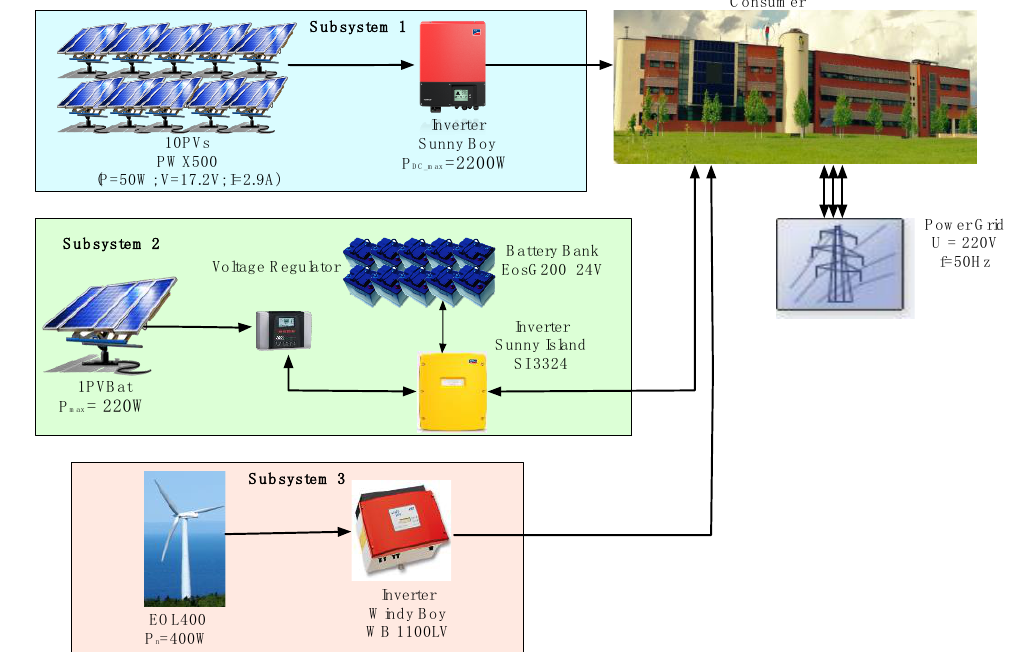
Figure 2. The developed hardware infrastructure—pilot microgrid.